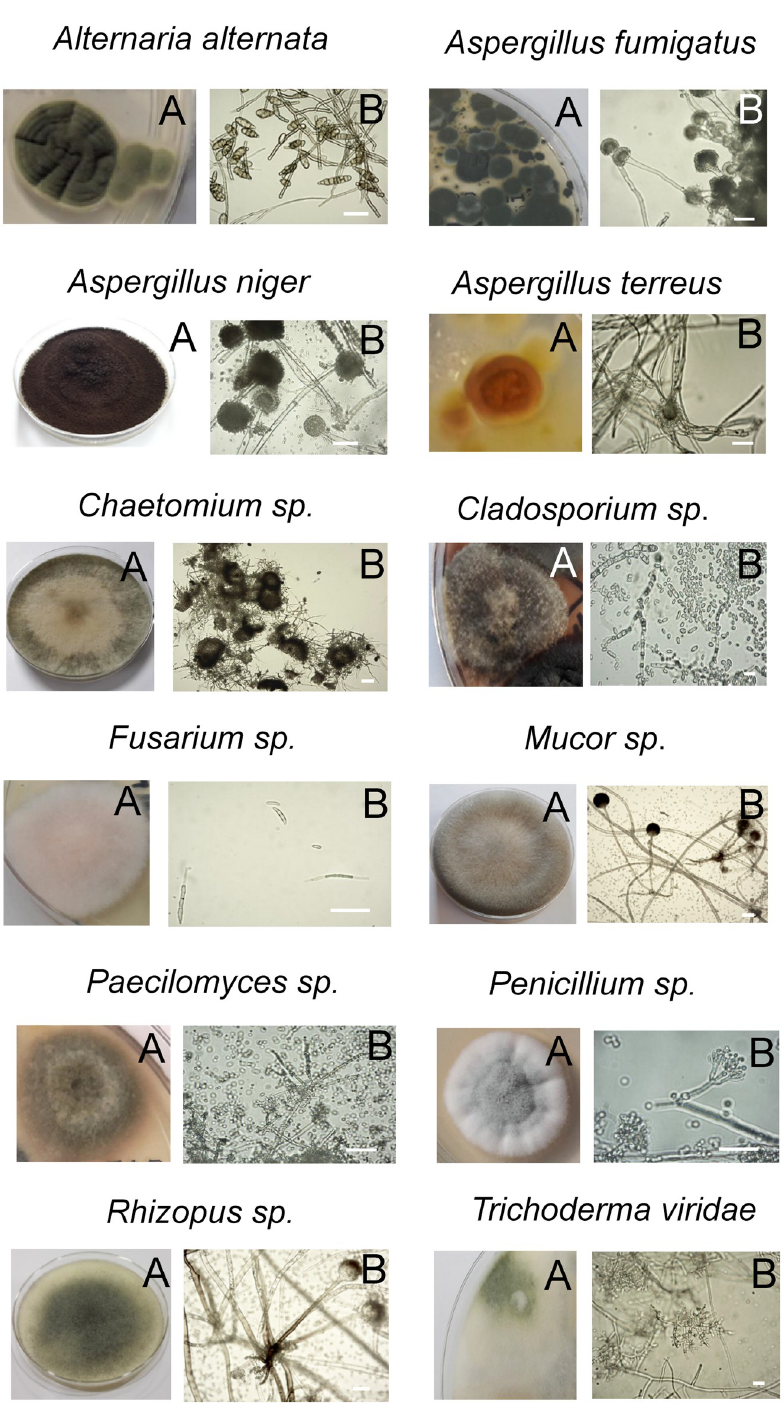
Fig 4. Fungi detected in Taraxacum officinale and soil samples. (A) macroscopic view of fungal colony, (B) microscopic image of the fungus. Scale bars: 20 μ m.